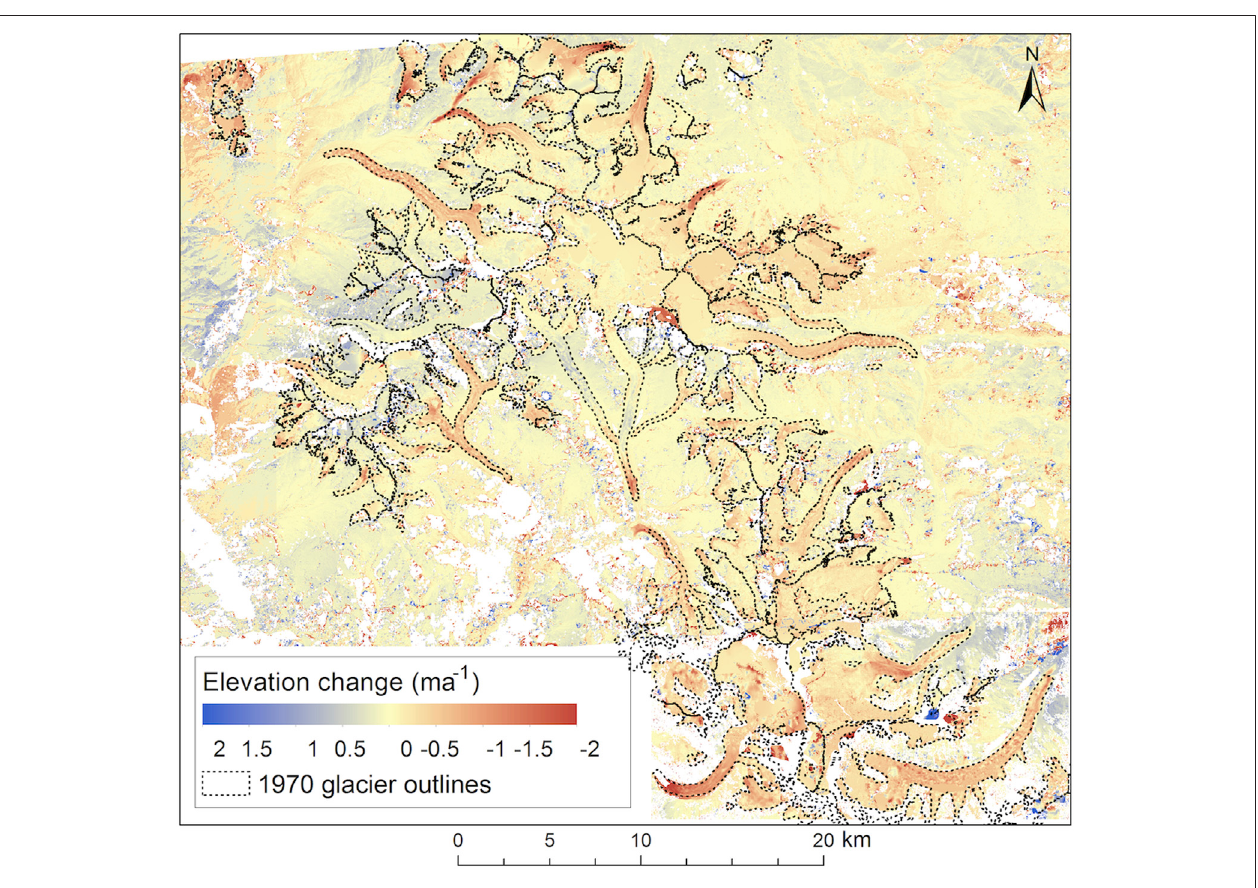
FIGURE 3 | Surface elevation changes for all glaciers over the full domain (Manaslu region) from 1970 to 2013.